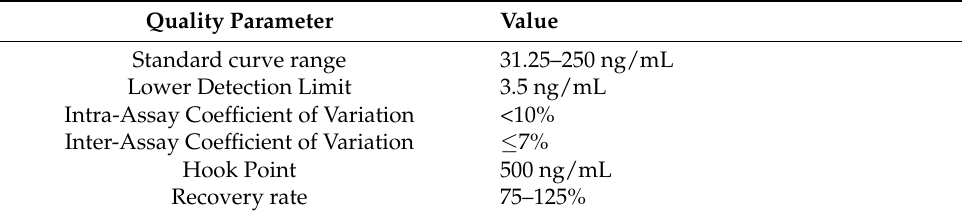
Table 1. Quality parameters for bovine interleukin receptor antagonist (IL1RA)